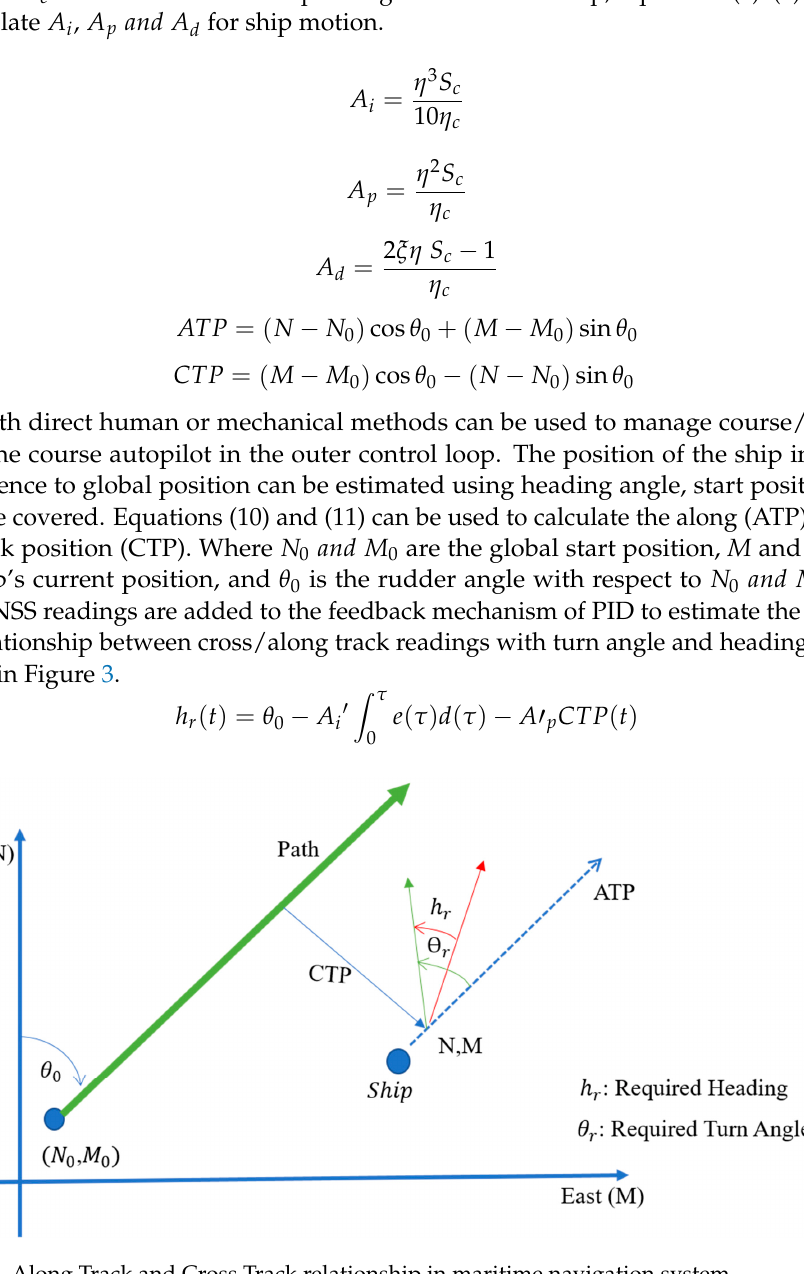
Figure 3. Along Track and Cross Track relationship in maritime navigation